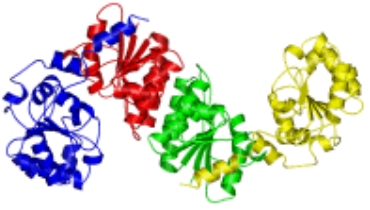
FIGURE 1 . (a) Original proposed pathway; (b) revised pathway.